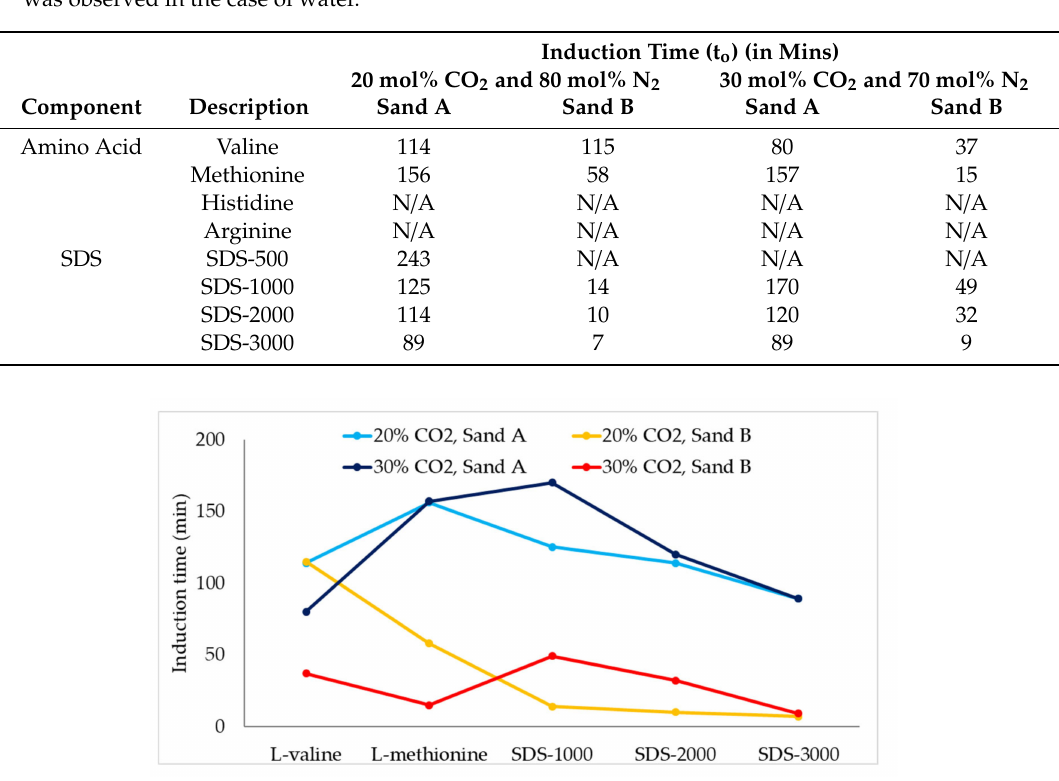
Table 2. E ff ect of CO 2 concentration on induction time, which is measured for amino acids (3000 ppm) and SDS (variable concentration), using two di ff erent sediments with di ff erent particle sizes. Initial pressure and temperature conditions are 120 bar and 1 ◦ C (N / A = no formation). No Sharp drop was observed in the case of water.